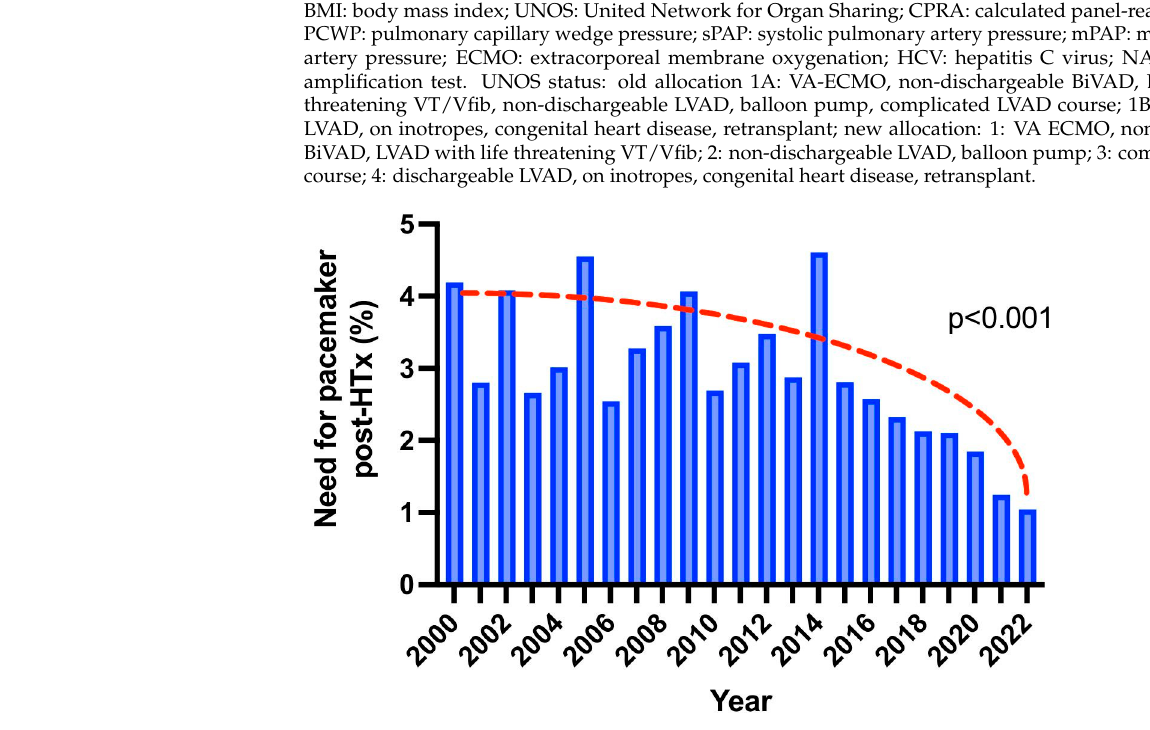
Figure 1. Bar plots indicating the trend of need for pacemaker implantation post heart transplantation over the years.